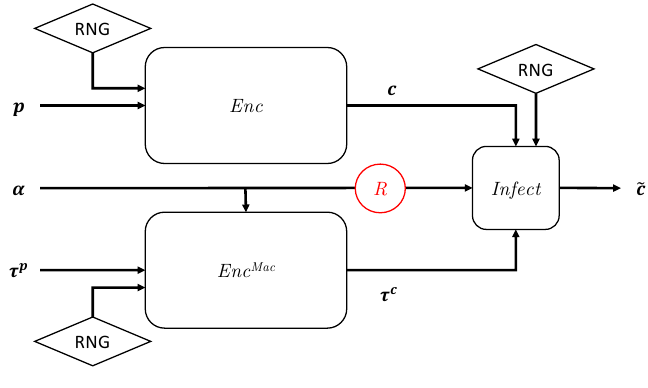
Figure 7: Overview of the